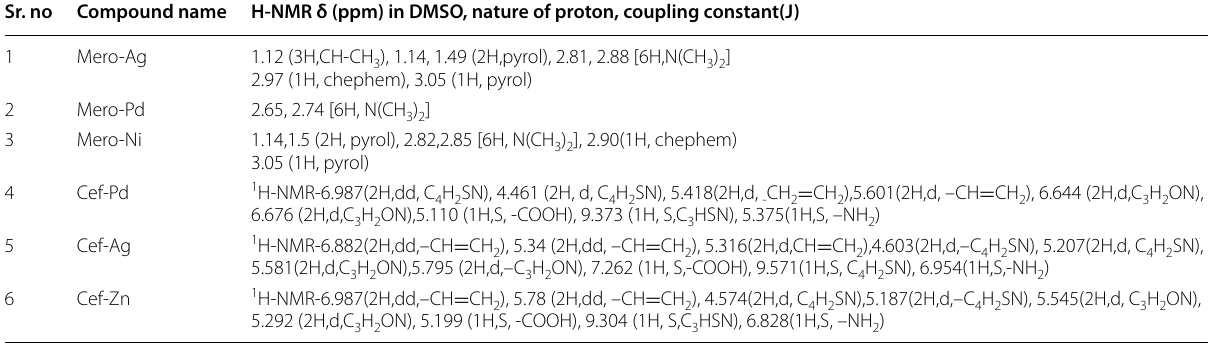
Table 2 1 H-NMR peaks of meropenem and cefixime metal ion complexes